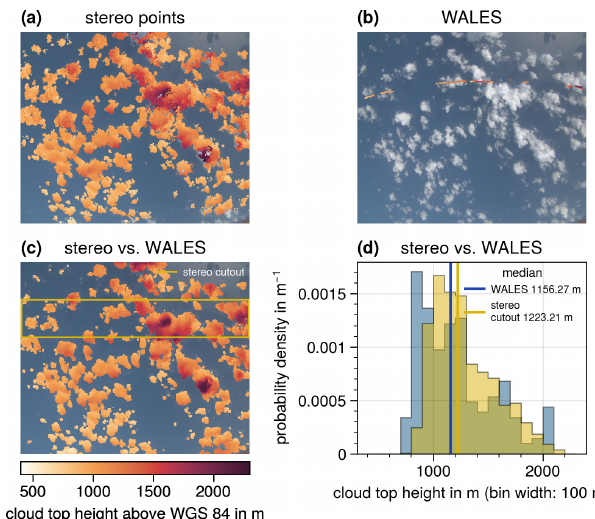
Figure 10. Cloud top height (CTH) data of the case study of small cumulus clouds (2 February 2020, 18:29:30UTC). Panel (a) shows the CTH of stereo points from the stereographic reconstruction method, panel (b) presents the CTH from the WALES lidar system, and panel (c) shows the interpolated CTH based on the stereo points. The WALES CTH is plotted on top. The stripe marked by the yellow lines indicates a specMACS cutout surrounding the WALES track. Panel (d) shows the probability densities of the CTHs of the spec- MACS cutout (yellow) and the WALES measurements (blue). The RGB measurement of the cloud field is shown in the background of panels (a) , (b) , and (c) . The color bar below panel (c) corresponds to all cloud top height measurements shown in panels (a) , (b) , and (c)